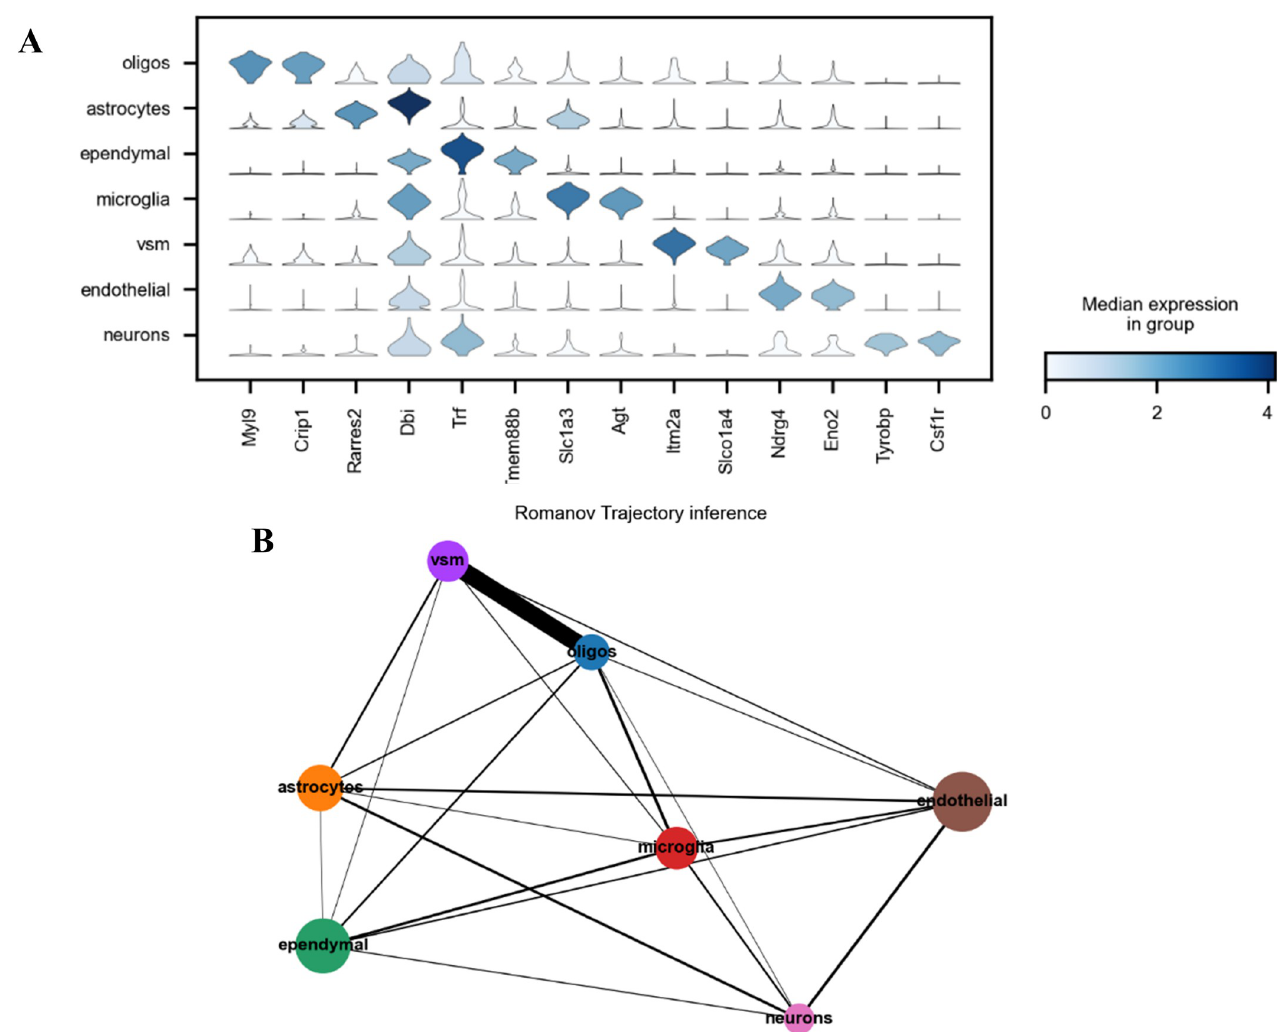
Fig 4. The results of marker genes and cell trajectory inference. A shows the distribution of candidate marker gene expression on different types of cells. The left side lists seven cell types, and the lower side lists the marker gene names. The shape of each violin approximates the expression distribution of the marker gene on the cell, and the shade of color reflects the average expression level. B is the result of cell trajectory inference, which reveals the dynamic process of cell differentiation. Seven different colored dots correspond to seven different cell types, and the size of the dots reflects the number of